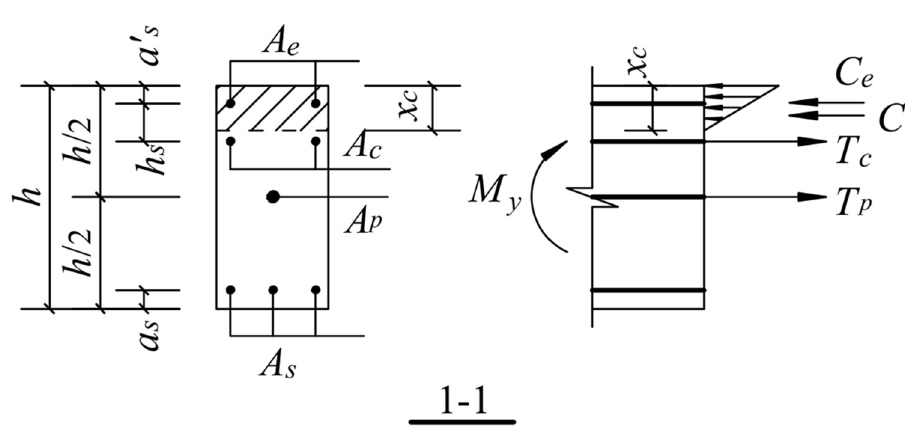
Fig 30. Schematic diagram of the yield moment calculation for upward